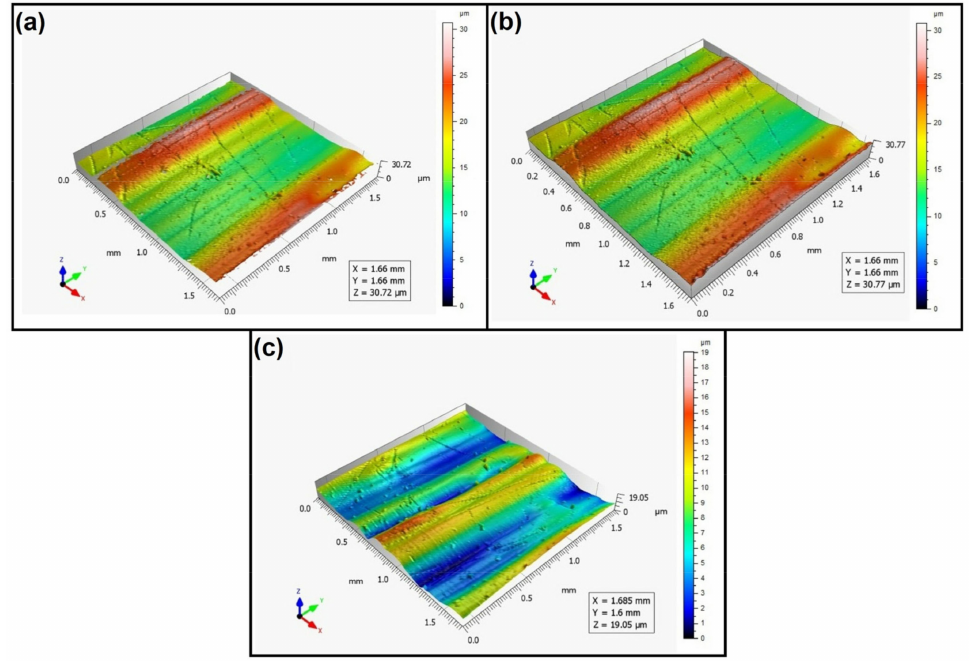
Figure 10. Surface topography of the element 3D printed using PJM technology (Pd = 45 ◦ ). ( a ) Talysurf CCI—without filling non-measured points, ( b ) Talysurf CCI—after filling non-measured points, ( c ) Talysurf PGI 1230.